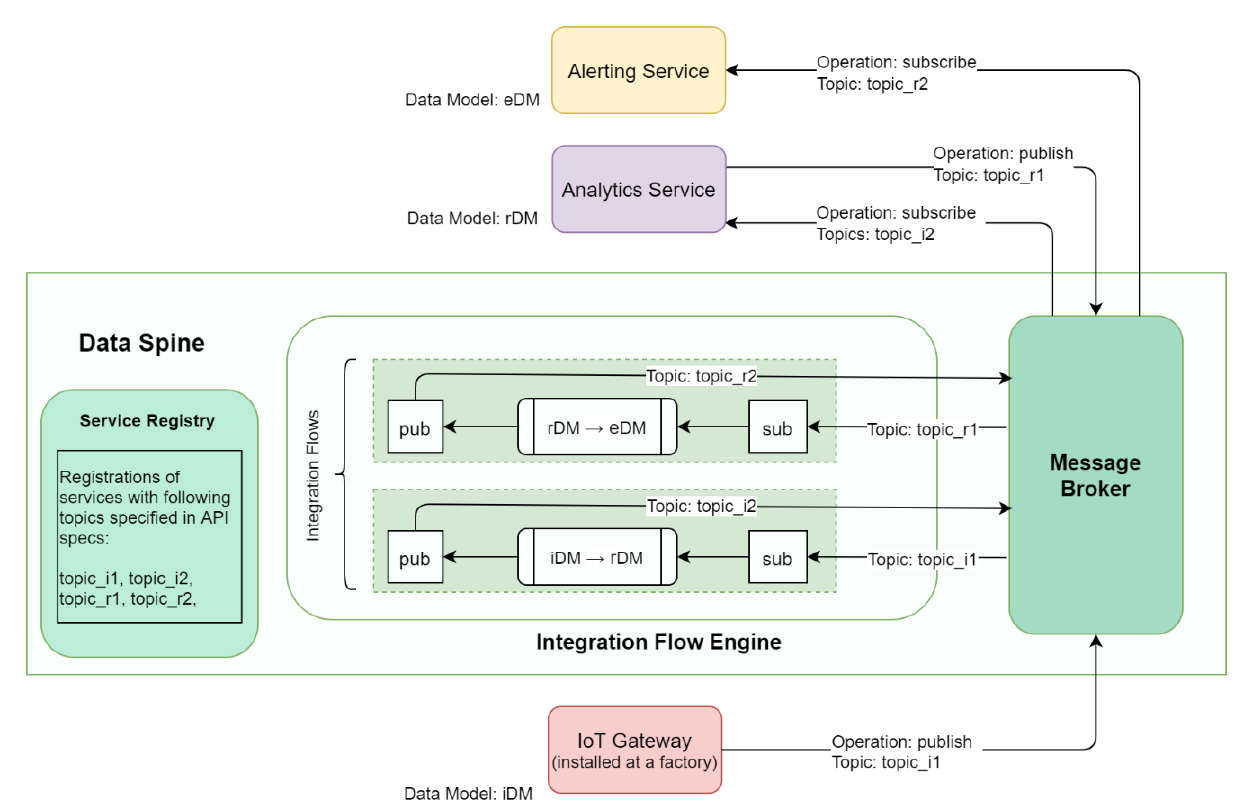
Figure 14. Realisation of a composite anomaly detection and alerting application in the EFPF ecosystem.